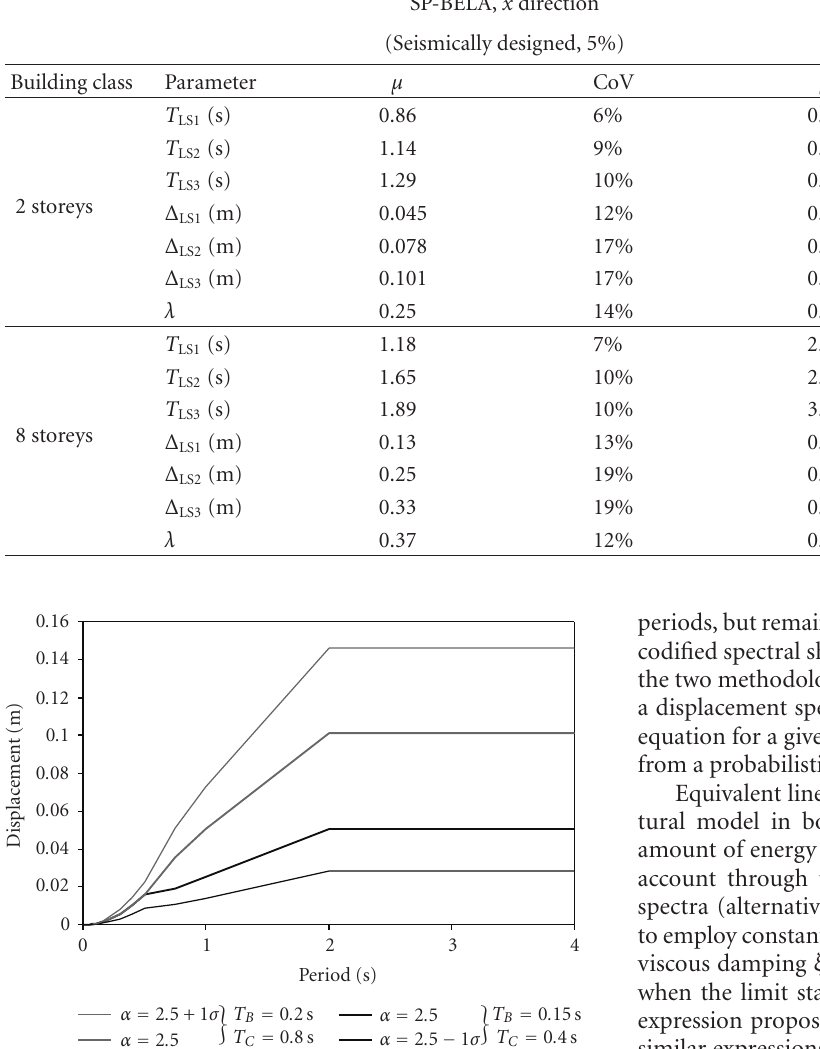
Table 4: Comparison of periods of vibration, displacement capacity, and collapse multipliers in DBELA and SP-BELA (in x direction). SP-BELA, x direction DBELA